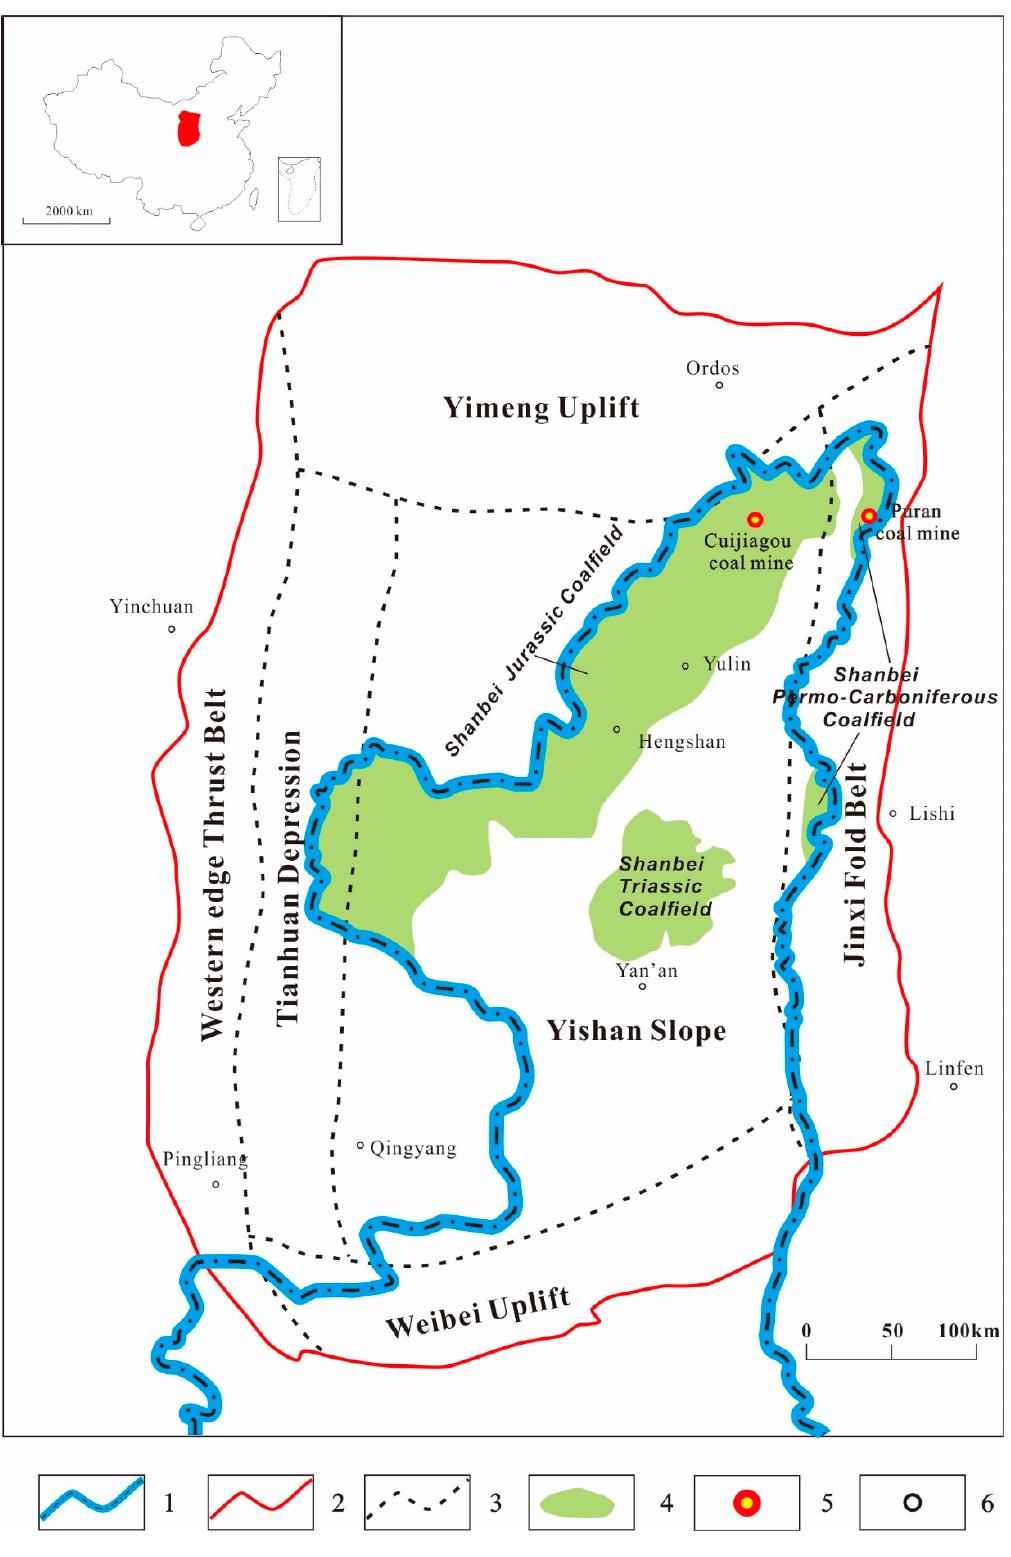
Figure 1. Geological map of Ordos Basin showing the location of the Shanbei Coalfield (Modified from Wang et al., [35]). 1. province boundary; 2. Ordos basin boundary; 3. tectonic unit boundary; 4. Shanbei Coalfield; 5. study coal mine; 6. main city in Ordos basin.